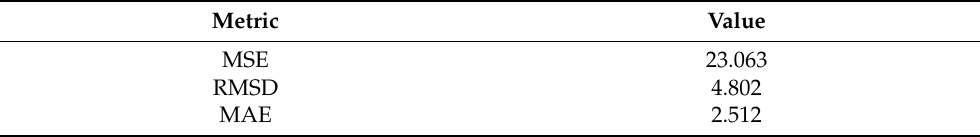
Table 8. Quantitative assessment of the load prediction